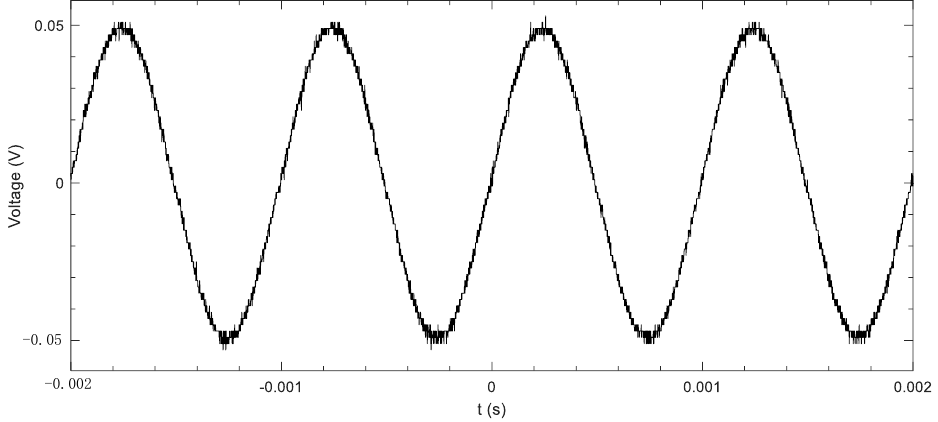
Figure 13. Measured coupled waveforms. It can be seen that the waveform in the figure is the superimposed waveform of a sinusoidal signal, which contains the reference signal component and the signal component to be measured; the measured signal is separated by FFT using MATLAB, and the data waveform is calculated and reduced to compare with the measured waveform of the Tektronix probe, as shown in Figure 14.